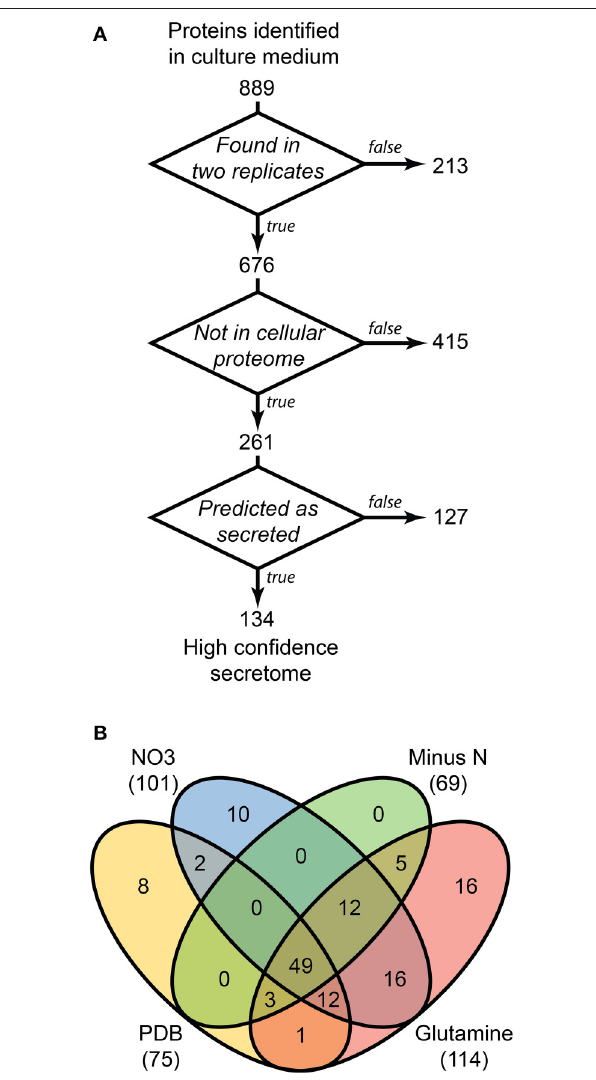
FIGURE 3 | Distribution of 134 proteins detected in secretome samples and absent from the cellular proteome. An overview of the three-step selection process for the high-confidence secretome is shown in (A) . The distribution of protein identifications in the high-confidence secretome across the four in vitro conditions is shown in (B) .